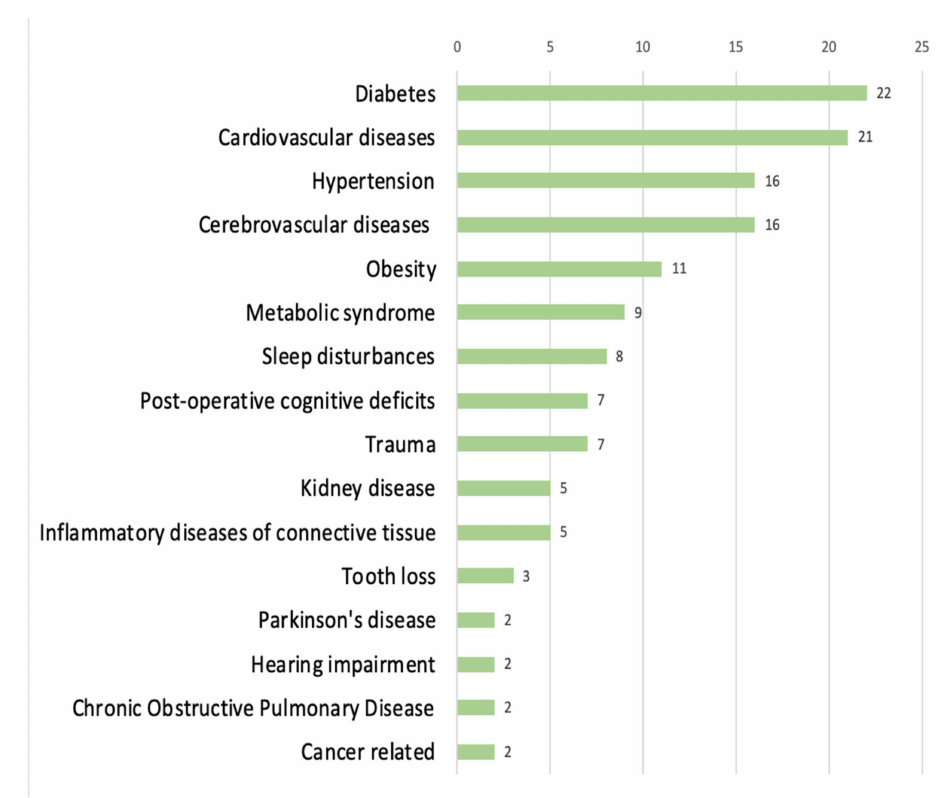
Figure 3. Frequency of reported factors grouped into the subcategory ‘somatic